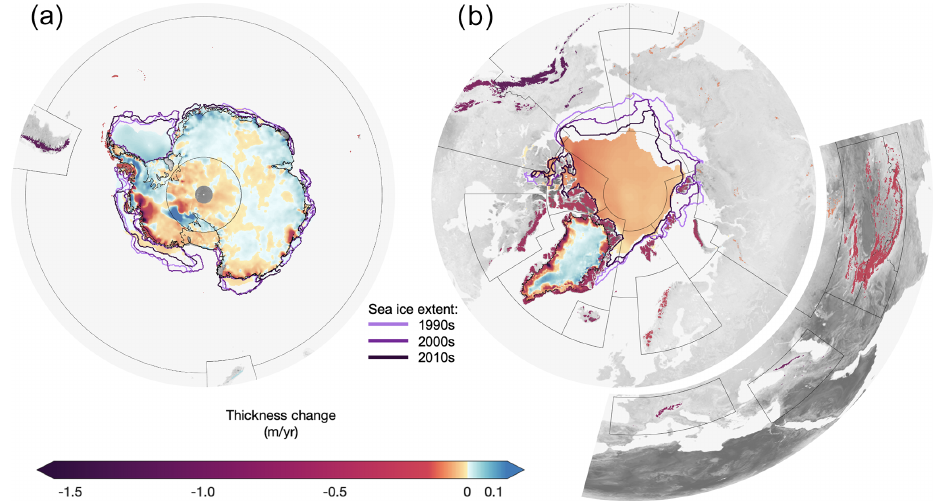
Figure 1. Average rate of ice thickness change in the (a) Southern Hemisphere and (b) Northern Hemisphere. Changes in Antarctic (1992– 2017) and Greenland ice sheet (1992–2018) thickness were estimated using repeat satellite altimetry following the methods of Shepherd et al. (2019). Sea ice thickness trends between 1990 and 2019 are determined from numerical sea ice and ocean modelling (Zhang and Rothrock, 2003), as well as the average minimum of sea ice extent in February (Antarctic) and September (Arctic) (purple lines) for each decade during the same period. Glacier thickness change between 1992 and 2018 for glacier regions defined in the Randolph Glacier Inventory (RGI Consortium, 2017) (black boundaries) are from mass change estimates (Braun et al., 2019; Foresta et al., 2016; Jakob et al., 2020; Tepes et al., 2021; Wouters et al., 2019; Zemp et al., 2019b) which have been converted to a thickness change assuming an ice density of 850kgm − 3 . The black circle at the south pole indicates the southern limit of the orbit of ERS and ENVISAT satellite altimeters, which were in operation between 1992 and 2010. The area between 81.5 and 88 ◦ S has been covered by CryoSat-2, which launched in